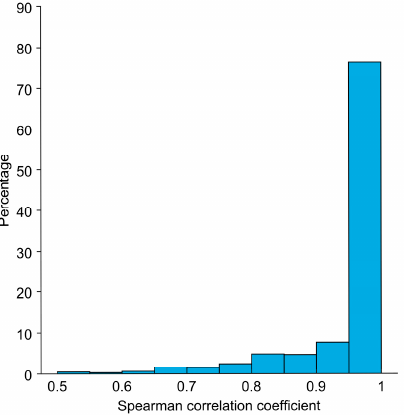
Figure 6. Spearman correlation coefficient histogram between the excess phase of the actual B 3 and the excess phase of the single − frequency occultation reconstructed B 3* .